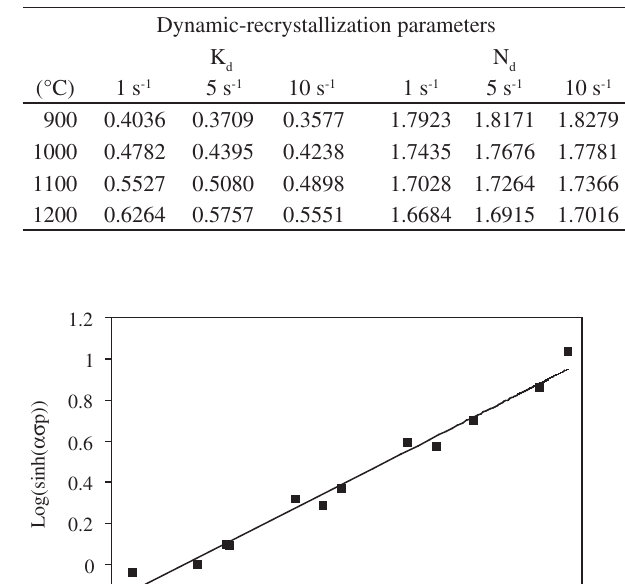
Work-hardening parameters